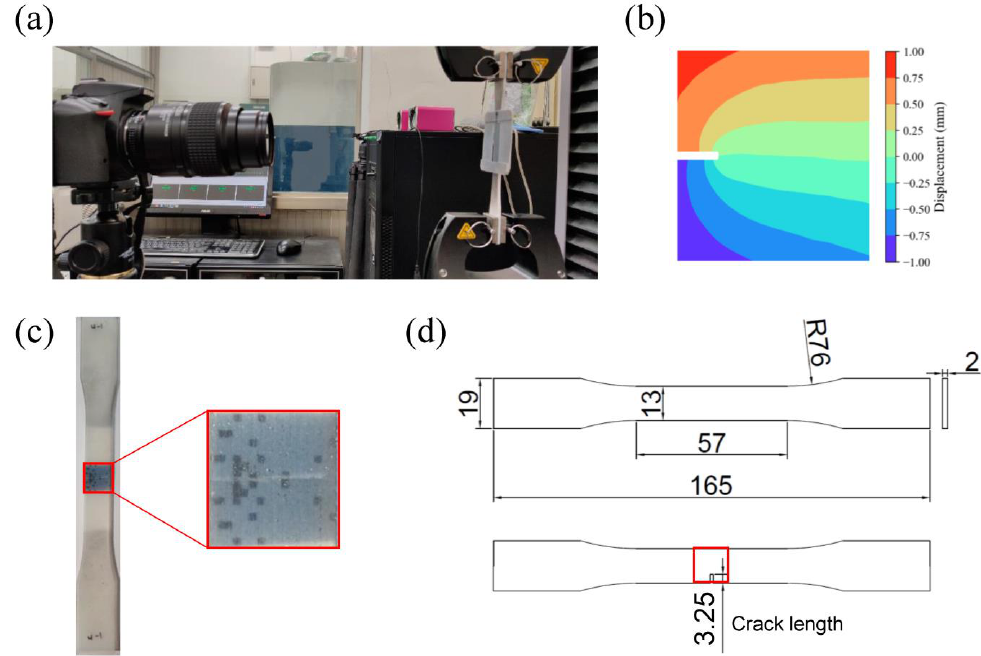
Figure 3. ( a ) Experimental setup for the tensile test with DIC. ( b ) Sample displacement field calculated using DIC. ( c ) picture of a sample specimen. ( d ) Dimension of the specimens. The red box is the design area. Unit: mm.